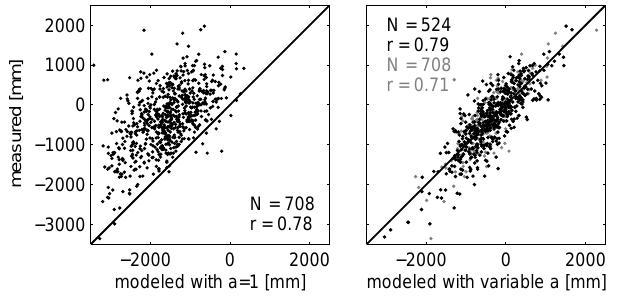
Fig. 2. Modeled versus measured mass balances for all mea- sured years. Left: results for a = const . = 1. Right: results for a = a optimized (see Eq. 5). Gray dots in the right panel indicate the values of those glaciers that were rejected from the final set based on the results of the cross validation procedure. Black numbers show the results for all the glaciers accepted into the final set, gray num- bers show the results for all glaciers. Values of r are based on the cross validation described in Sect.